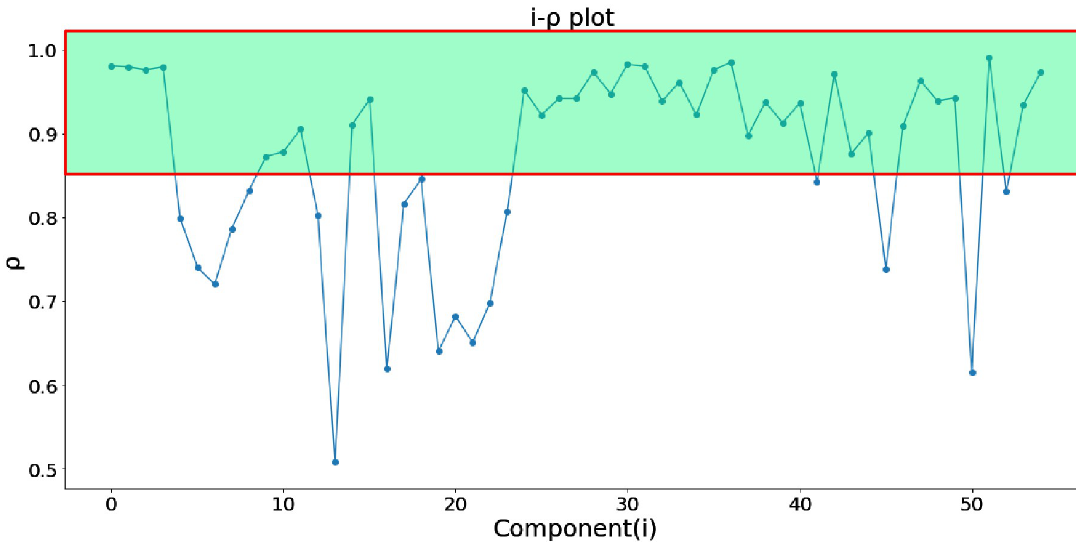
Fig 10. Screening of the first s maximum autocorrelation